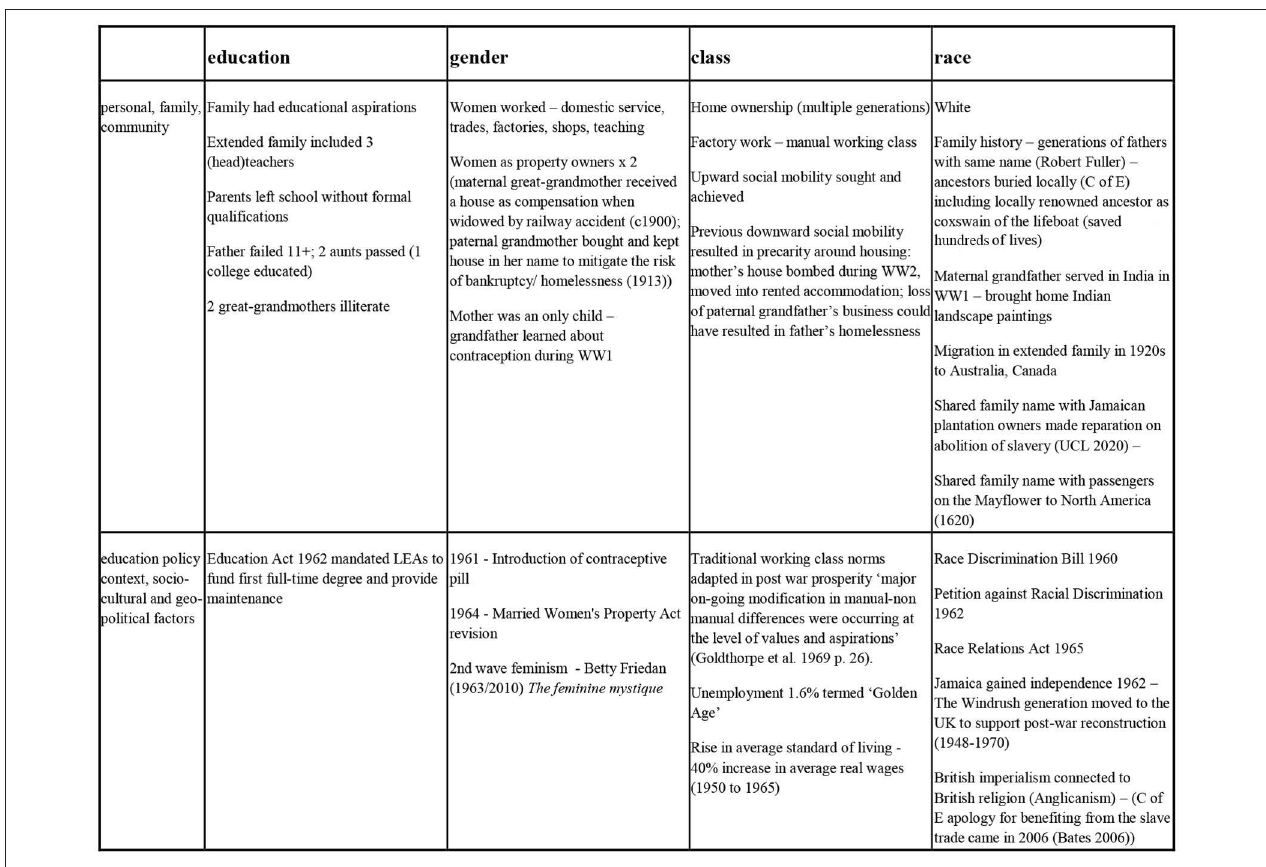
FIGURE 1 | Example of ‘7 up’ intersectionality life grid (birth −